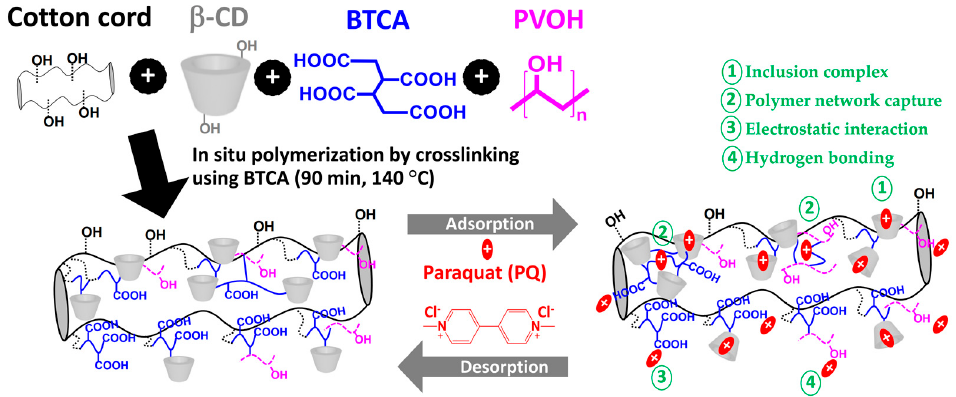
Figure 1. Coating reaction of modified cord and the possible adsorption mechanism with paraquat.